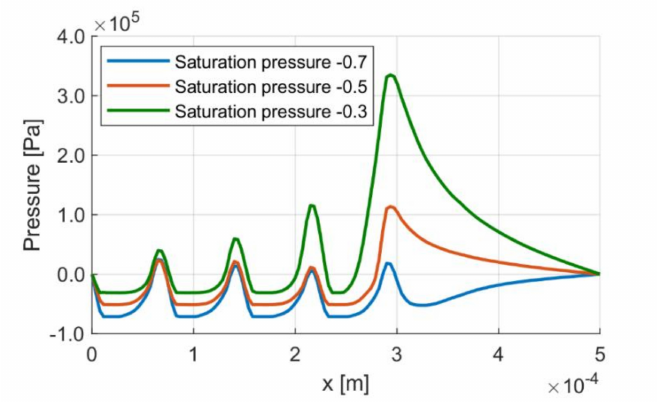
Figure 29. Pressure profiles calculated along the dimples median line at di ff erent saturation pressures. Square dimples with side 50 µ m and gap 3 µ m, sliding velocity 10 m / s. Set B of the cavitation coe ffi